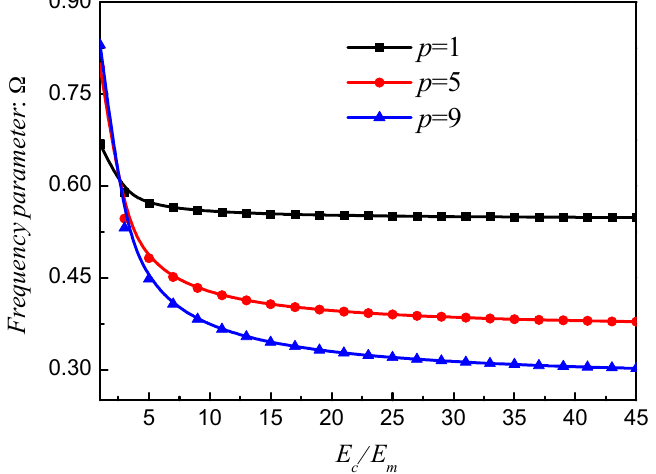
Figure 12. Results about different p and c of stepped FGM I ( a = 1; b = 0.5; c ; p ) paraboloidal shell.